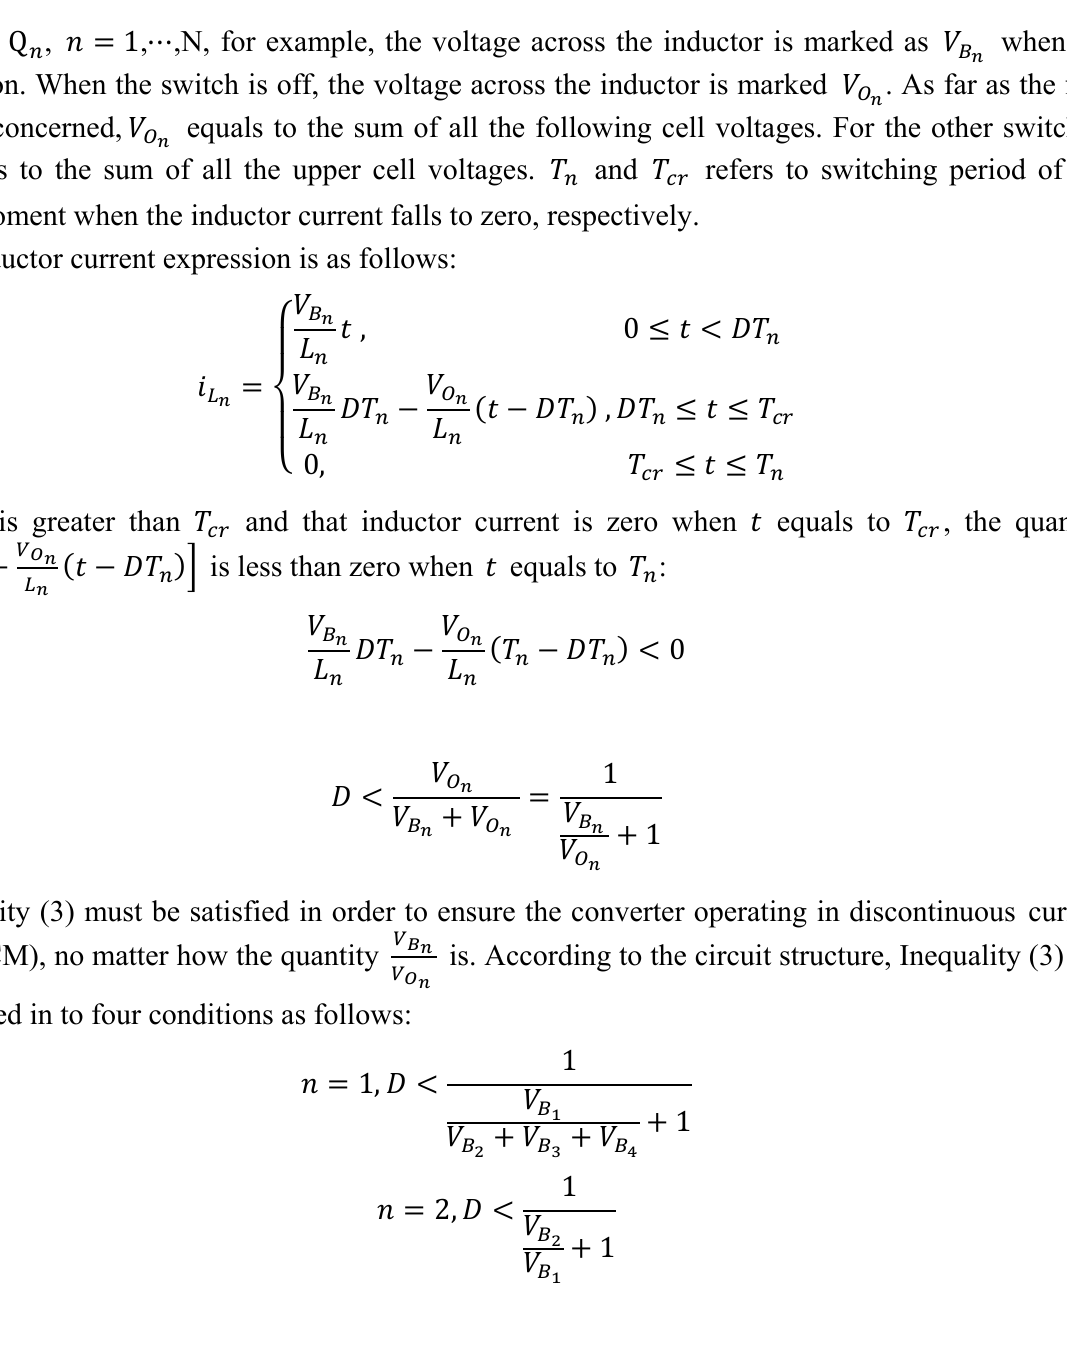
Figure 8. Discontinuous current